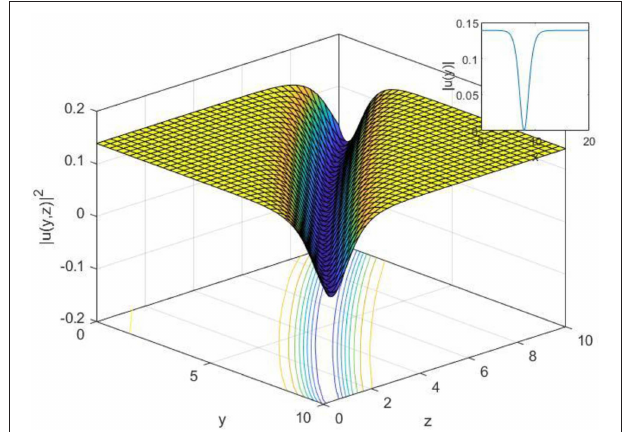
FIGURE 3 | 2-D, 3-D, and contour plot of dark soliton solution Equation (22) when λ 3, µ 1, β 0.1, α 0.9, ε 0.2, c 0.3, t 2, γ 3, = = = = = = = = a 0 1, b 0 2 and z 2 for 2-D. = = =